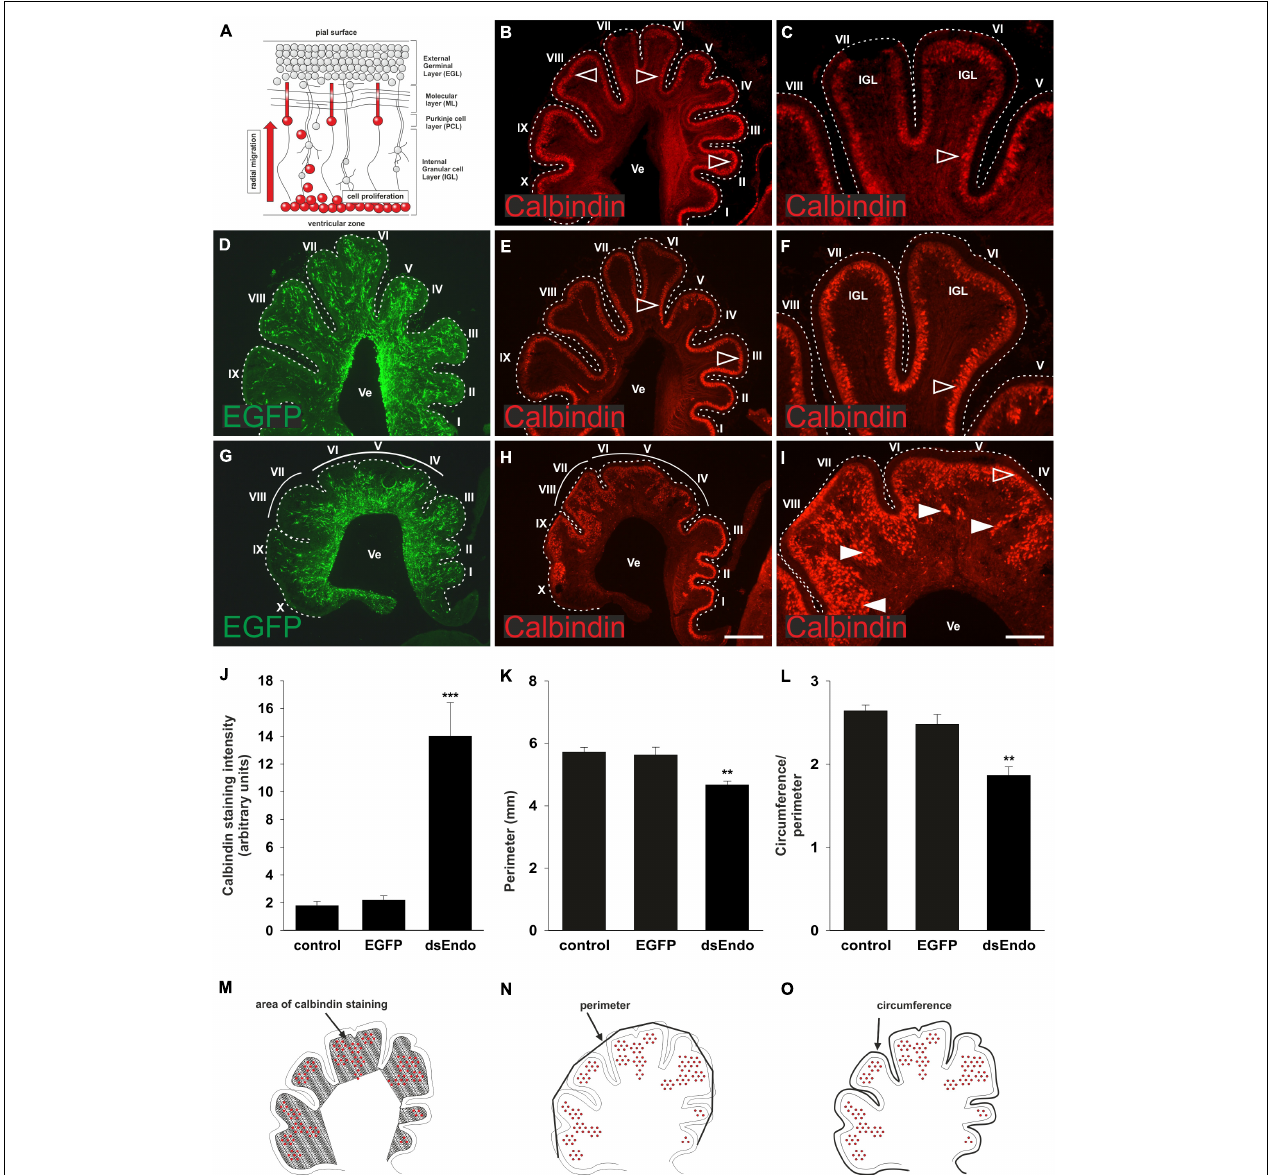
FIGURE 3 | Endoglycan is required for Purkinje cell migration. Purkinje cells are born in the ventricular zone and migrate radially toward the periphery of the cerebellum, while granule cells proliferate in the external germinal layer (EGL; A ). In the cerebellum of untreated chicken embryos sacrificed at HH38, Purkinje cells have reached the periphery of the developing folds (B) . Higher magnification of lobes VI and VII reveals that cells have reached their destination but have not yet finished the alignment to a single cell layer (C) . The developmental trajectory and the distribution of Purkinje cells is not different in control-treated embryos sacrificed at HH38. Control-treated embryos were injected and electroporated ex ovo at HH34 with the EGFP-expressing plasmid alone (D–F) . In embryos injected and electroporated with the EGFP plasmid and dsRNA derived from Endoglycan (dsEndo), the cerebellum failed to develop the characteristic lobes. They were much shorter and failed to segregate properly (G–I) . There was a striking failure of Purkinje cells to migrate toward the periphery. Arrowheads indicated clusters of Purkinje cells that failed to migrate and reach the periphery of the cerebellum. Open arrowheads indicated the correct location of Purkinje cells. For quantification, we measured the Calbindin-positive areas as a proportion of the area of the lobes in parasagittal sections (J,M) . There was no difference between the distribution of Purkinje cells, measured as Calbindin-positive pixels between non-treated and control-treated embryos (1.88 and 2.29, respectively). However, the area of the folds containing Purkinje cells was drastically increased, despite the fact that the area of the lobes was strongly reduced (14.05; *** p = 0.0008 for dsEndo vs. EGFP, *** p = 0.0004 for dsEndo vs. non-treated control). The circumference of parasagittal sections of the cerebellum (K) , as outlined in (N) was significantly smaller for the sections taken from embryos injected and electroporated with dsEndoglycan (4.67 compared to 5.72 for untreated and 5.63 for EGFP controls; ** p = 0.0043 for dsEndo vs. EGFP controls, ** p = 0.0013 for dsEndo vs. non-treated controls). Finally, to have a relative measure for the lack of lobe separation, we divided the outer circumference (as shown in N ) and divided the value by the circumference of the same parasagittal sections when the length of the folds was included (L,O) . Values were 2.64 for untreated controls, 2.48 for EGFP expressing controls, 1.87 for dsEndo group. ** p = 0.0026 for dsEndo vs. EGFP, *** p = 0.0002 for dsEndo vs. non-treated controls. Lobes are labeled by Roman numbers. IGL, inner granule cell layer; Ve ventricle. One-way ANOVA with Tukey’s multiple comparisons test used for statistical analysis.